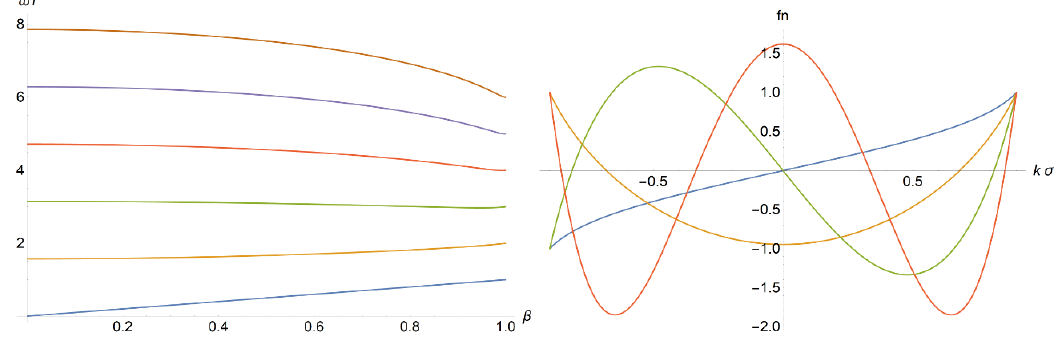
Figure 1 . The (cid:12)rst few eigenfrequencies ( ! n ‘ ) for the transverse mode as a function of (cid:12) (left), and the (cid:12)rst few eigenfunctions plotted for (cid:12) = 0 : 9 (right). The modes are plotted in the gauge with R ( (cid:27) ) = (cid:27)